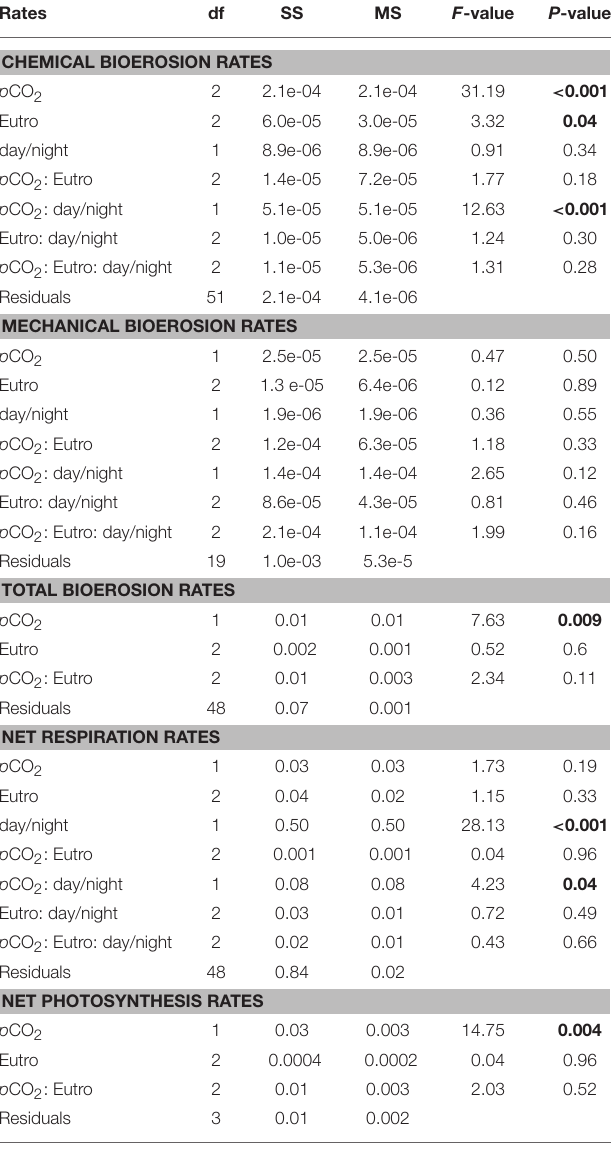
TABLE 5 | Three-way ANCOVAs, with bioerosion rates (chemical: A T change, TABLE 4 | Daily averages ( ± standard deviation) of total, mechanical, and mechanical: chip production, and total: buoyant weight) and net respiration rates chemical bioerosion rates in mg cm − 2 d − 1 . as dependent factors, eutrophication, and day/night as independent categorical E1 E2 E3 factors and p CO 2 as a continuous covariable. Rates